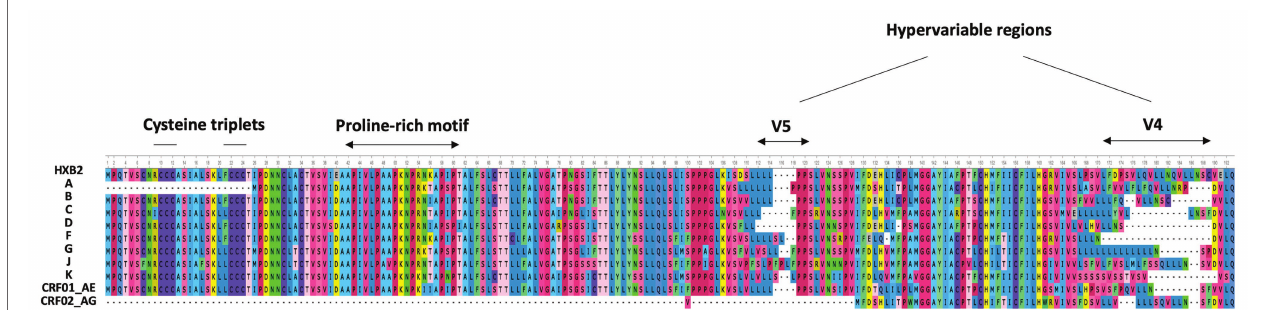
FIGURE 2 | Alignment of the consensus amino acid sequence of AntiSense Protein (ASP) encoded by the major subtypes and circulating recombinant forms (CRFs) of HIV-1 (sequences were retrieved from HIV-1 data bases, Los Alamos National Laboratory and analyzed using Unipro UGENE: a unified bioinformatics tollkit” Okonechnikov; Golosova; Fursov. Bioinfomatics 2012 28: 1166–1,167). The first line represents the reference HXB2 sequence of ASP. The main motifs of ASP are indicated.